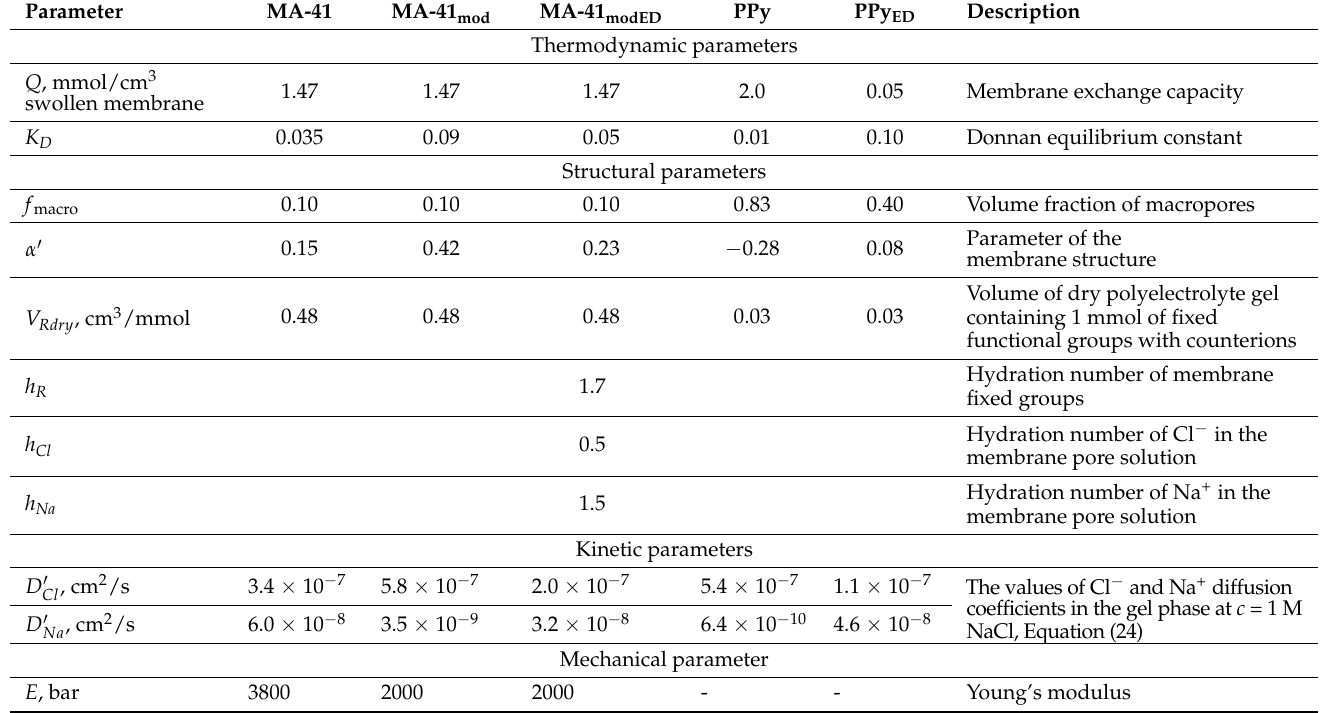
Table 1. The values of the input parameters of the